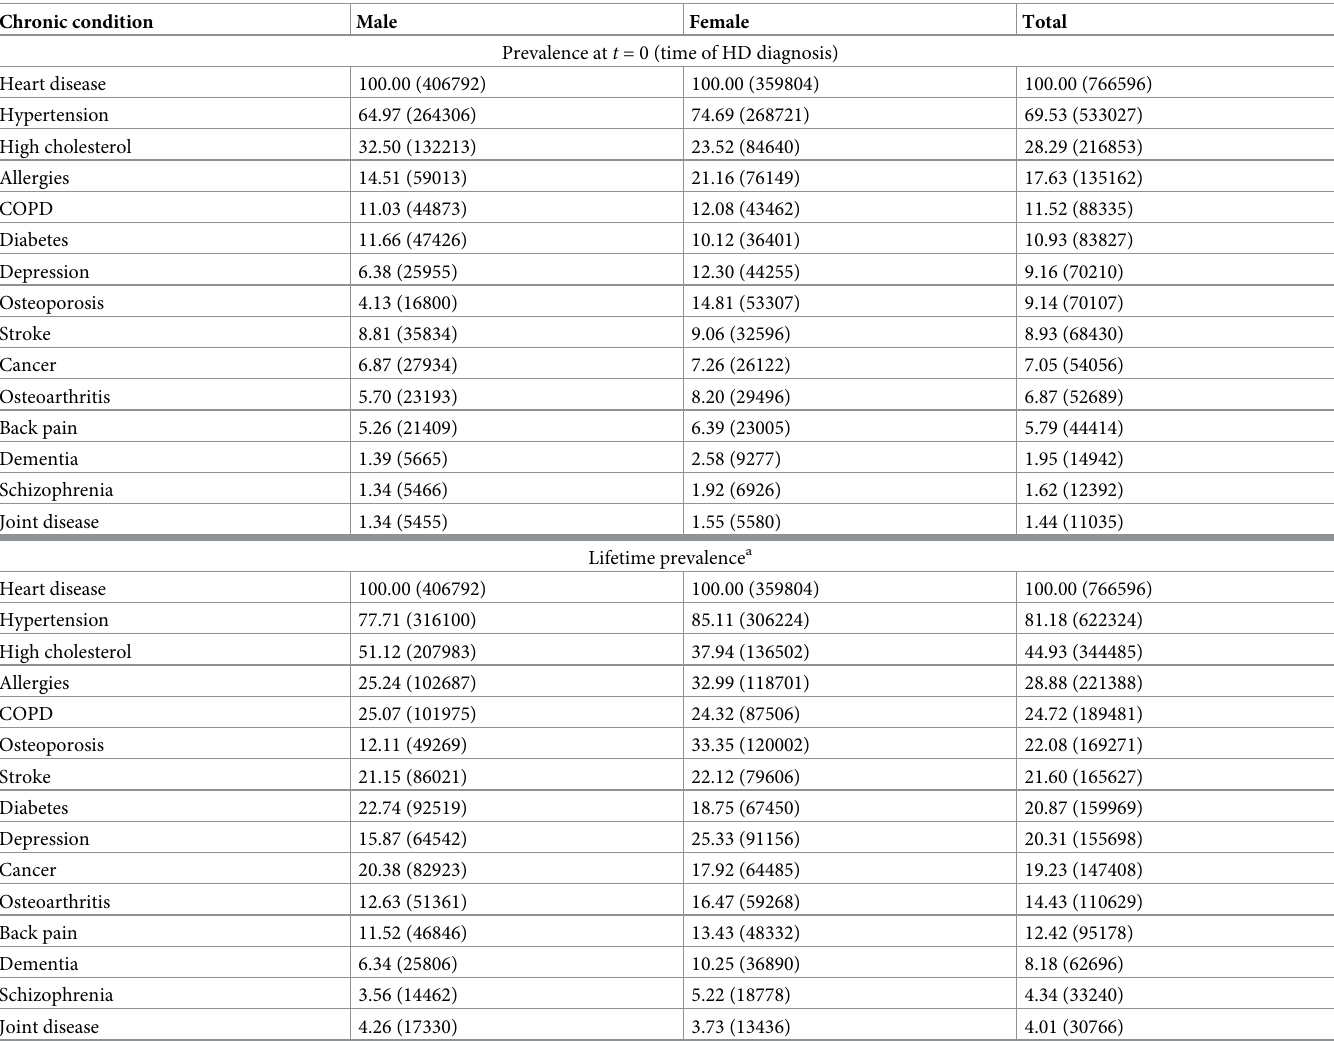
Table 3. Diagnosis prevalence of HD population according to sex. Prevalences are reported at time of HD diagnosis, as well as for the entire span of the observed disease trajectories. Chronic